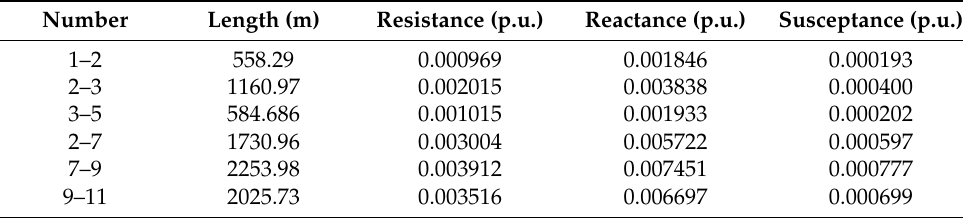
Table 18. Parameters of different power supply network lines with 110 kV.